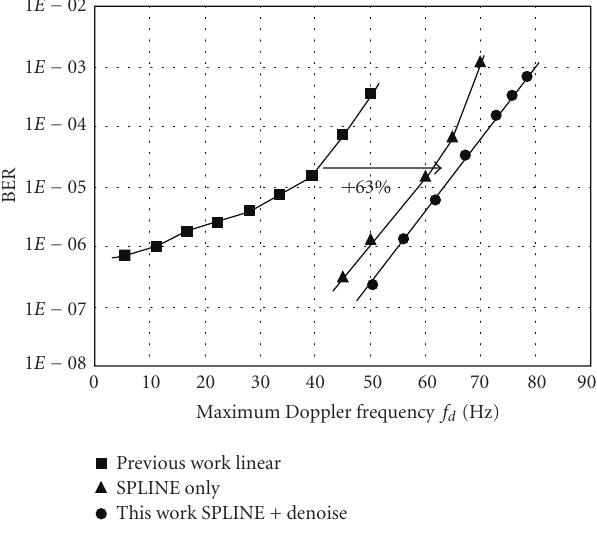
Figure 13: Mobile reception performance comparison of 2CD mode.